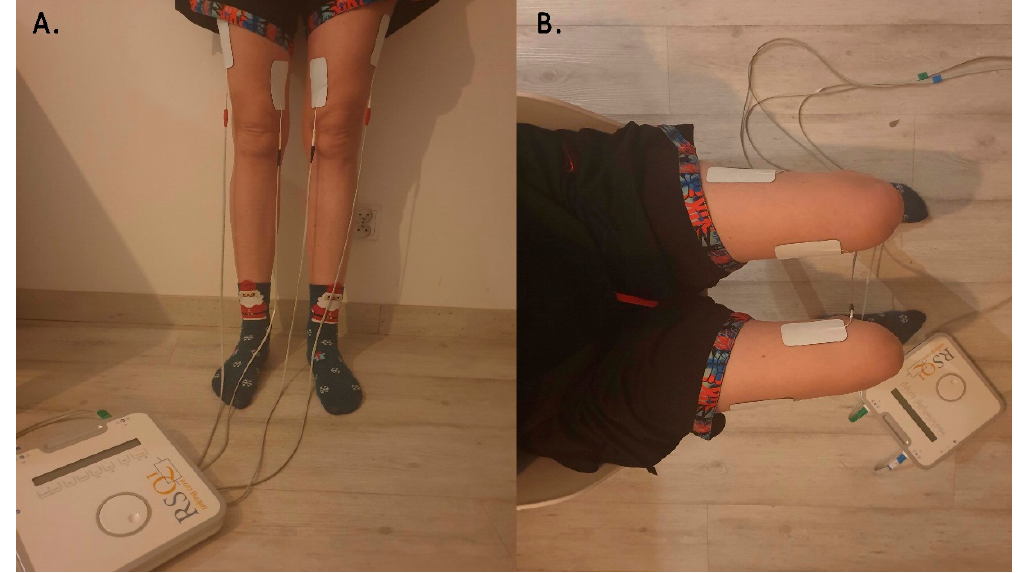
Figure 1. Placement of electrodes of the thigh and the RSQ1 device: ( A ) front view and ( B ) from above view.